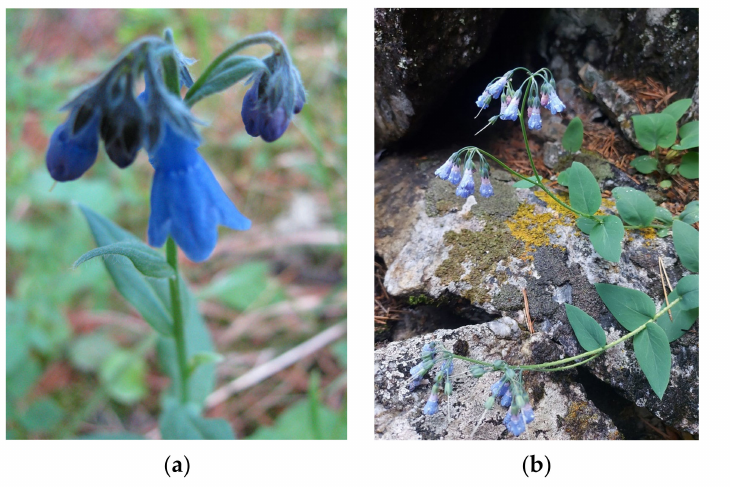
Figure 1. Mertensia species in their natural habitat: ( a )— M. stylosa (Fisch.) DC.; ( b )— M. serrulata (Turcz.)